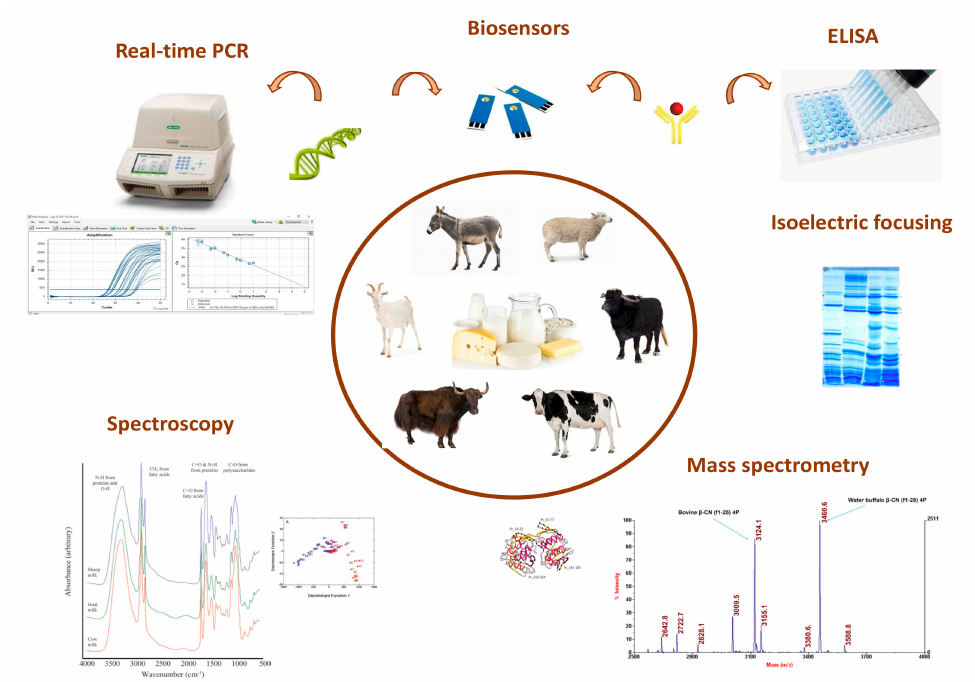
Figure 1. Graphical representation of analytical methods used for the authentication of animal species in dairy products. Adapted from [16,72], reprinted from [16,72] with permission from